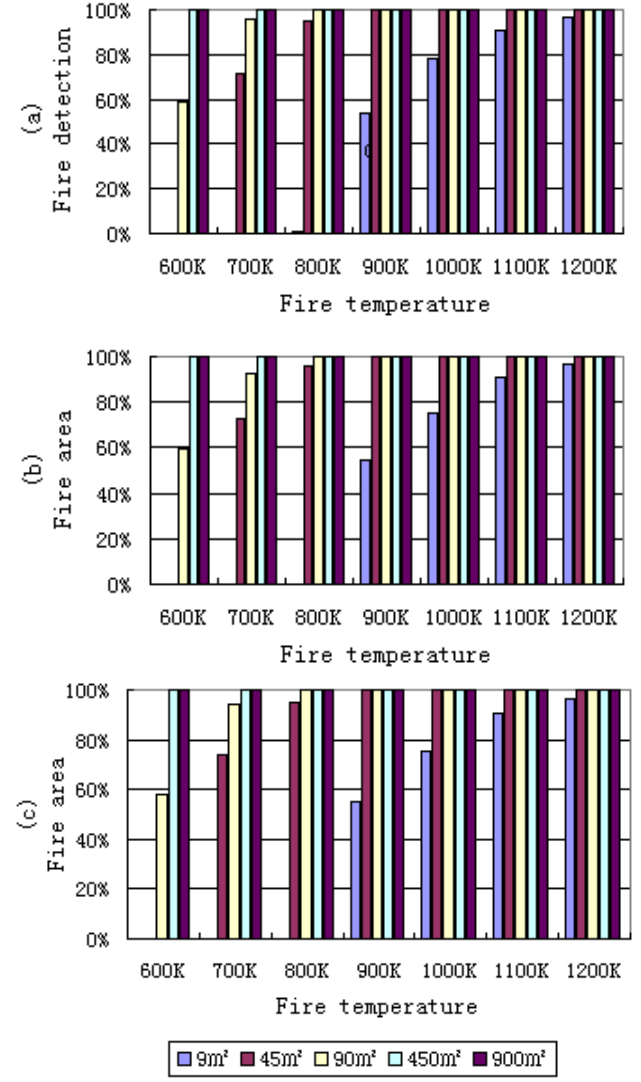
Figure 6. Probabilities of fire detection in nadir view for different fire areas (m 2 ) and temperatures (K) under standard atmospheric conditions with a visibility of 23 km; (a) tropical; (b) midwinter; (c)